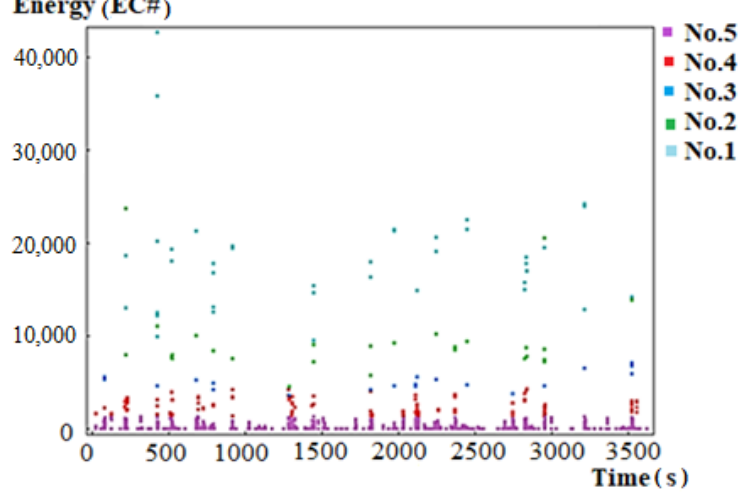
Figure 7. Energy–time relationship for node 1 in span 1 with the numbers of signal classes marked.